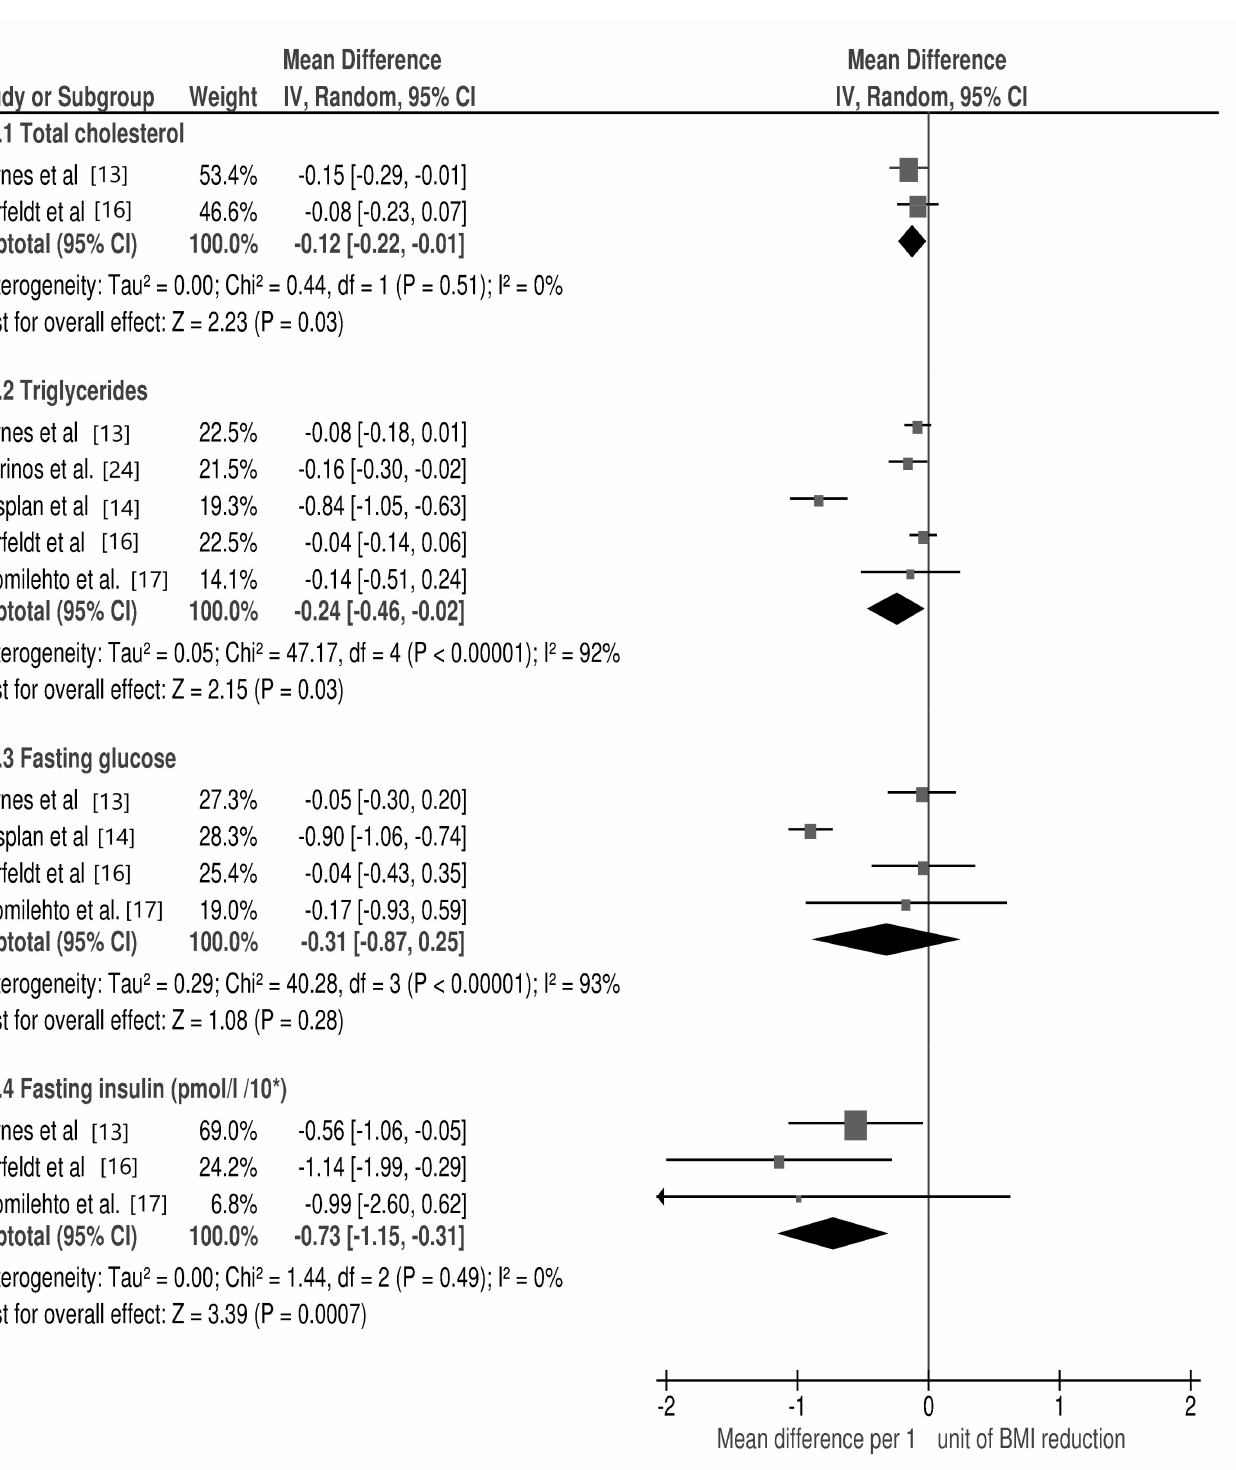
Figure 3. Forest plot for mean cardio-metabolic parameters change in subgroup analysis: total cholesterol, triglycerides, glucose, insulin per 1 unit of body mass index (BMI) reduction in selected